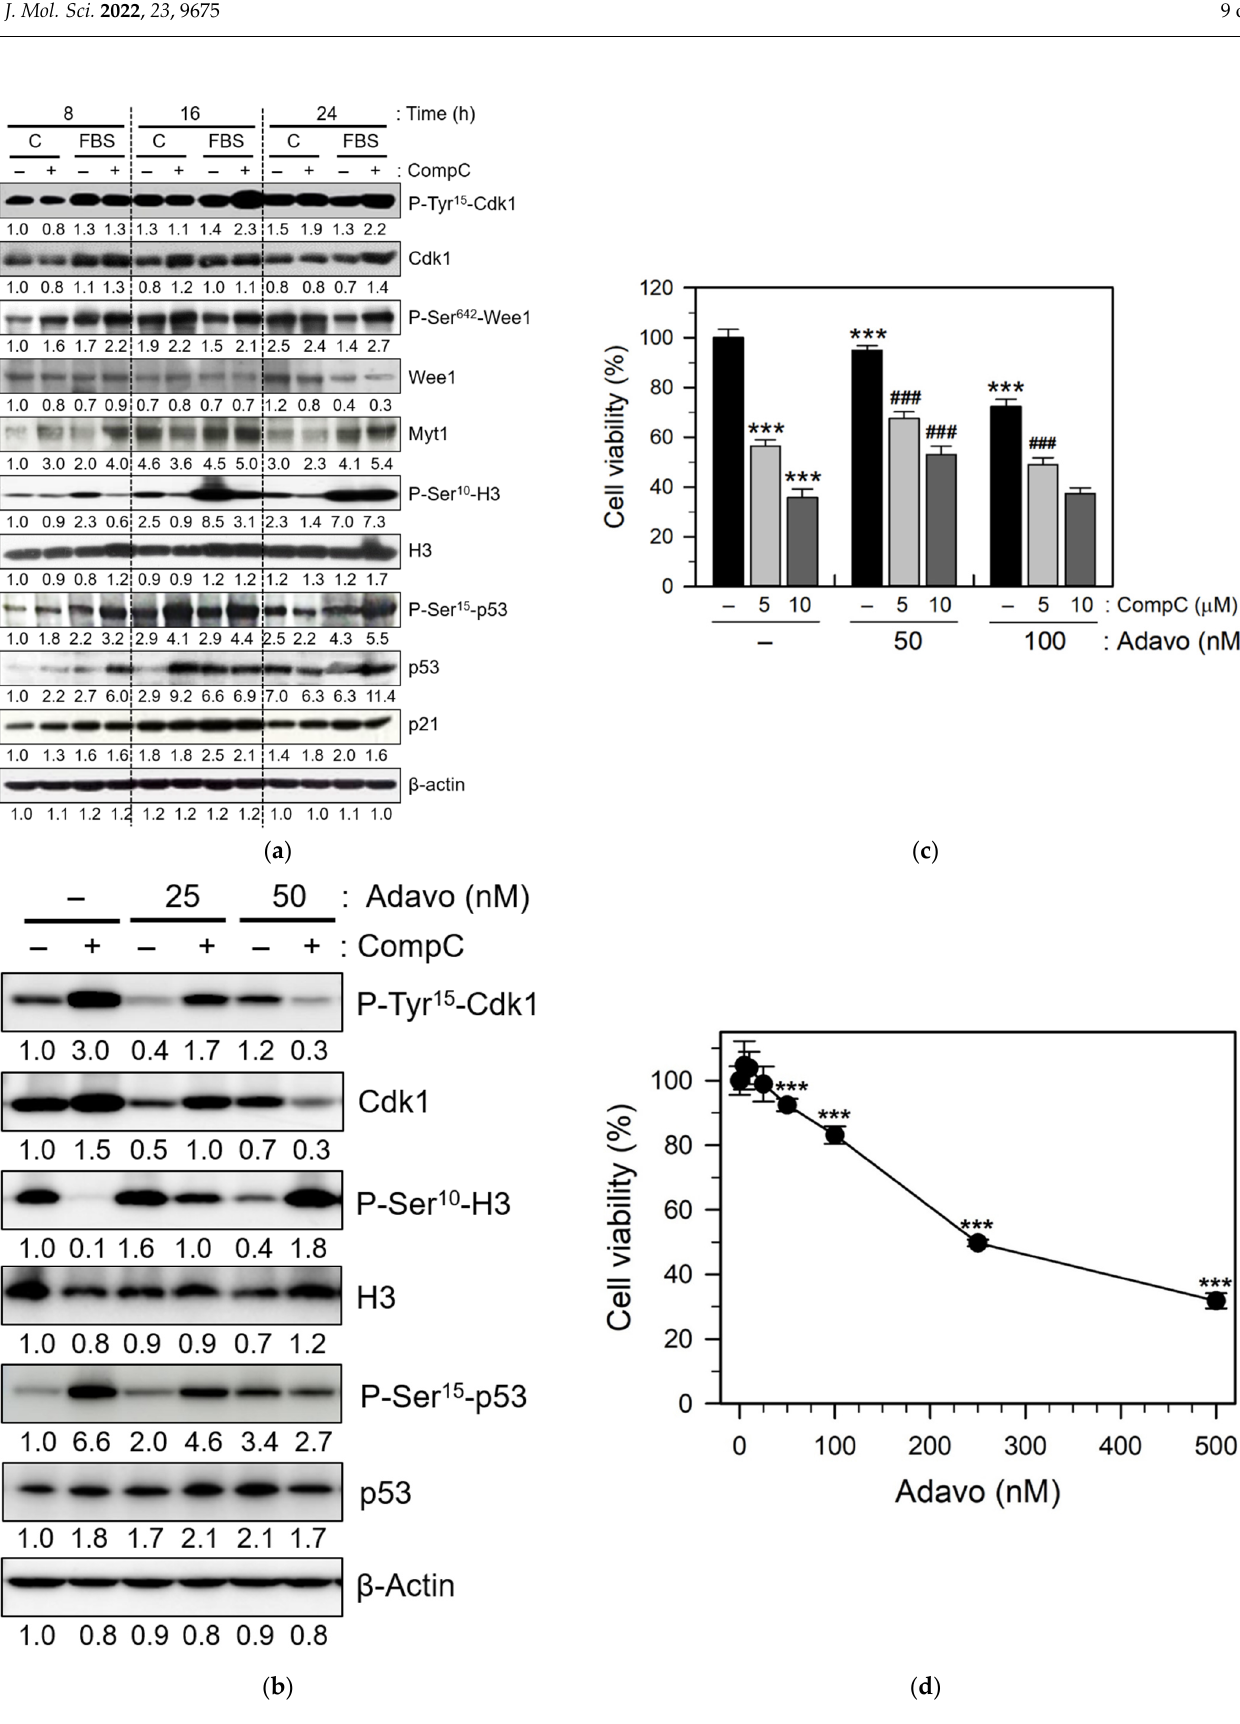
Figure 5. CompC increased the phosphorylation of Cdk1 on Tyr 15 and Wee1 on Ser 642 . ( a ) Renca cells were cultured for one day and then serum-starved by incubation with SFM overnight. The cells were treated with SFM (C) or 10% FBS for the indicated times (8–24 h) in the absence ( − ) or presence